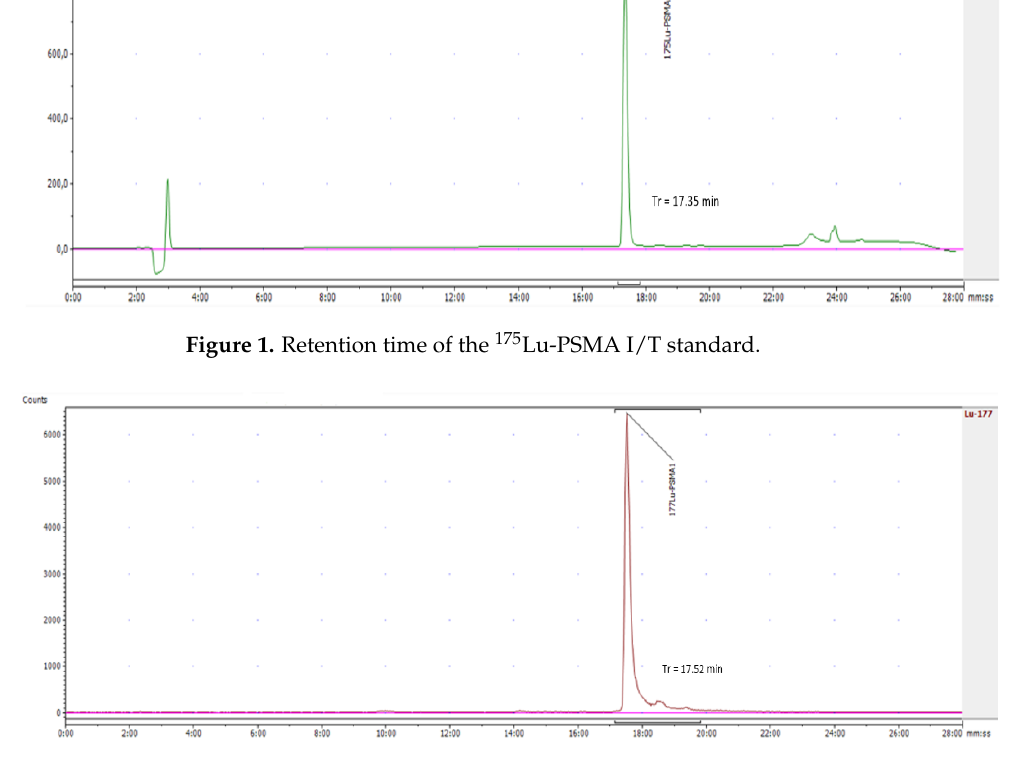
Figure 2. Retention time of 177 Lu-PSMA-1 complex.